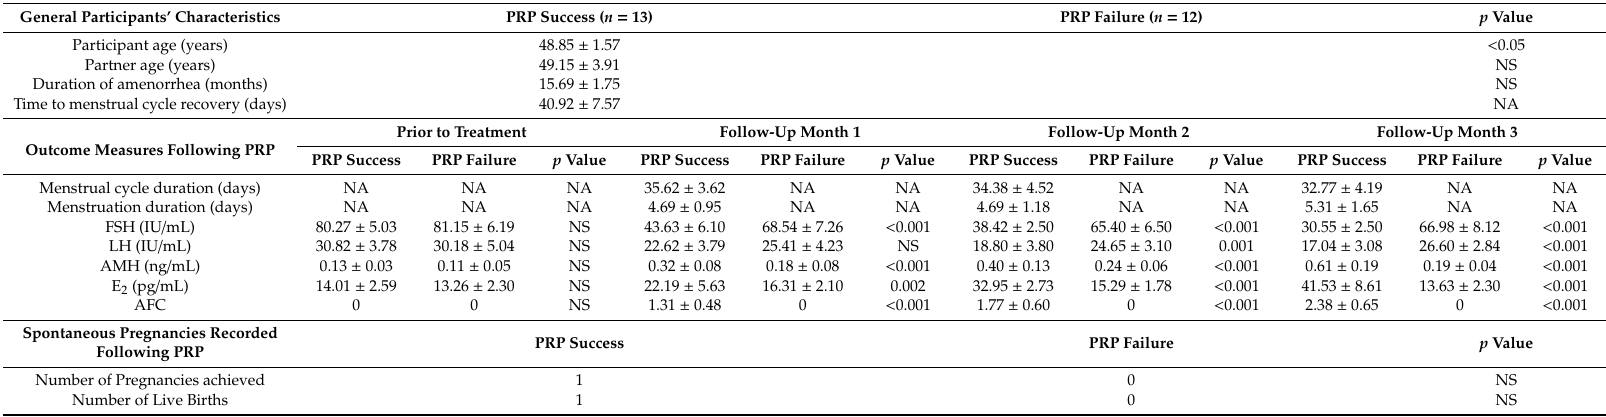
Table 5. Statistical analysis and outcome assessment prior and following PRP intraovarian infusion regarding the Menopausal pilot study. General Participants’